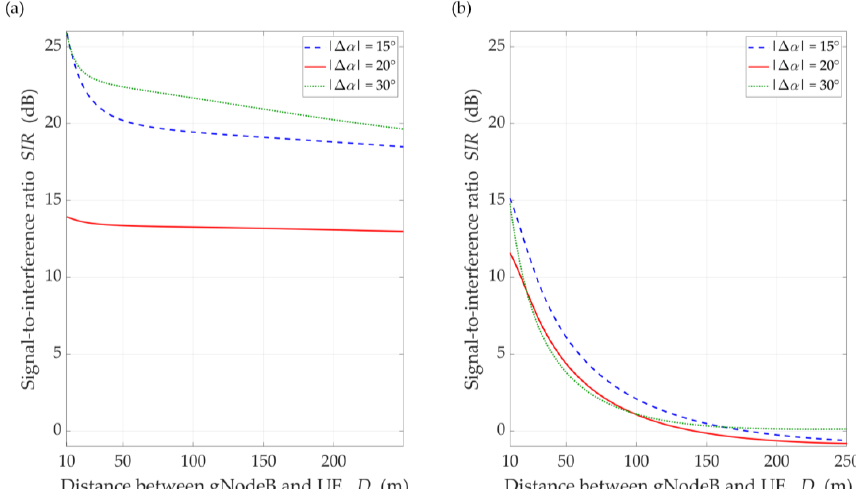
Figure 9. SIR versus distance for DL scenario, selected ∆ α = {15°, 20°, 30°}, under ( a ) LOS (TDL-D) and ( b ) NLOS (TDL-B) conditions.